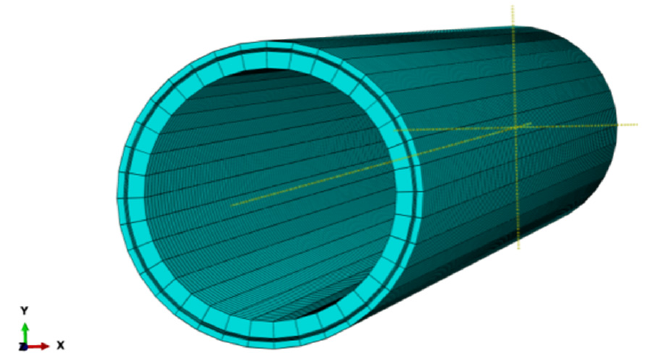
Figure 3. FEM model of RTP. Table 1. The geometrical parameters of RTP.